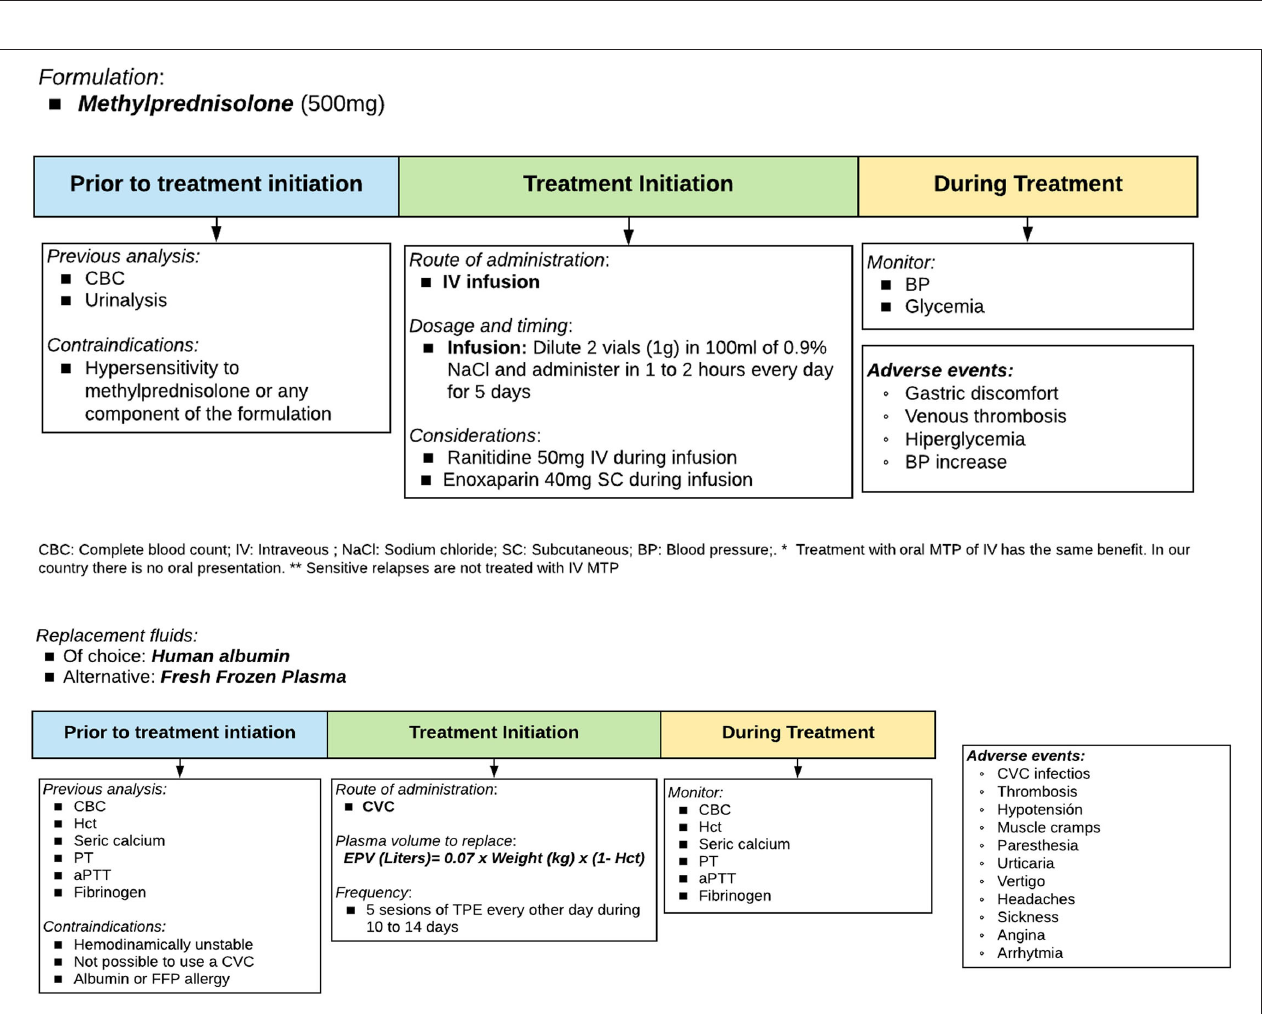
Frontiers in Neurology |